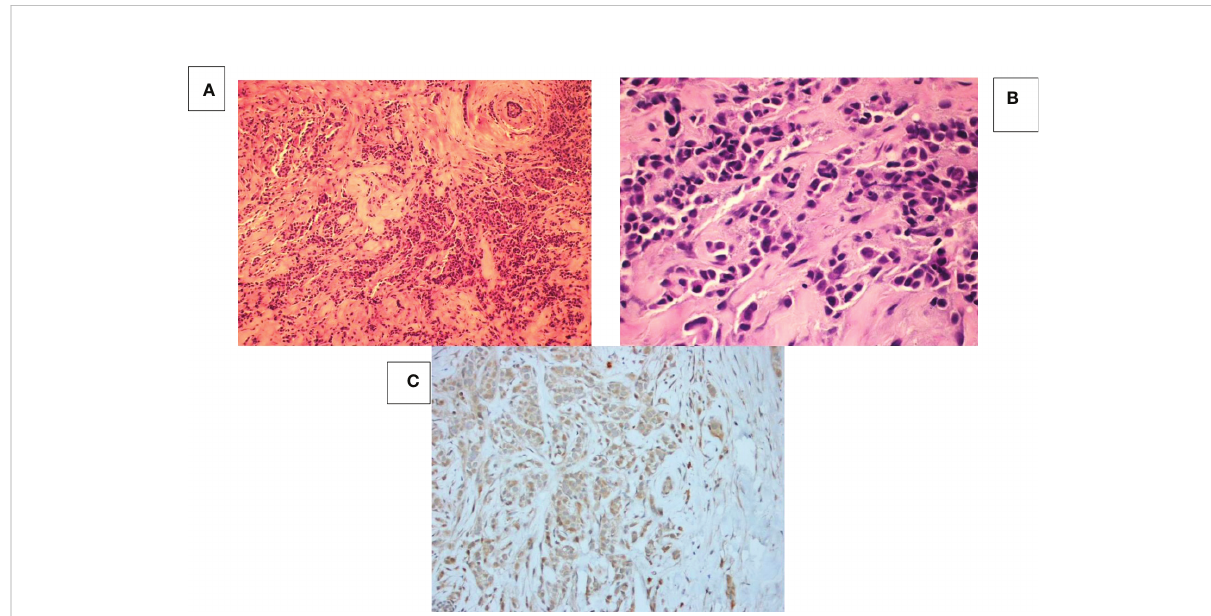
FIGURE 2 Breast mass at 6 o ’ clock position. (A) HE staining at 100x magni fi cation shows tumor cells with sheets, tubular, cords or single cell formation in fi ltrating through desmoplastic stroma. (B) HE staining at 400x magni fi cation shows moderately differentiated tumor cells with high nuclear: cytoplasmic ratio and pleomorphic hyperchromatic nuclei in fi ltrating through desmoplastic stroma. (C) hCG IHC shows that all the cancer cells are negative for